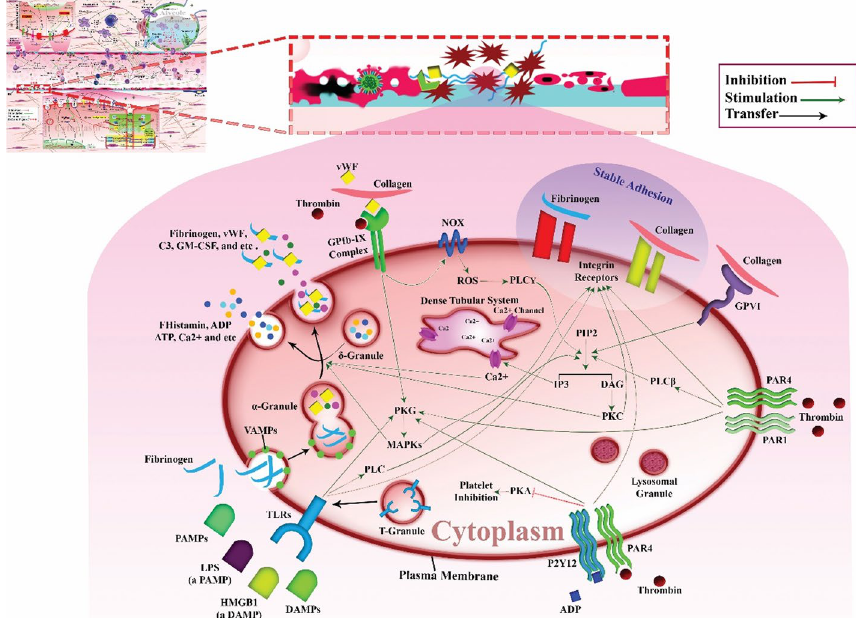
Fig. 3 Platelet receptor/signaling and COVID-19. Low platelet level in some patients with COVID-19 can be due to massively activated platelets. Platelets contain alpha, delta, T, and lysosomal granules. VAMPs may mediate platelet endocytosis. Fibrinogen normally imports into the platelet α-granules and is fused with vWF. Platelets have various receptors: integrins; GP Ib/IX/V; TLRs; thrombin receptors of PAR-1 and PAR-4; ADP receptor of P2Y12; GPVI. In viral infections, TLRs are activated that cause the secretion of complement C3 from alpha granules in platelets. They also release GM-CSF. Complement C3 and GM-CSF stimulate NETosis. SARS-CoV-2 pathogenesis indirectly induces an enhanced capability of VWF to bind to its receptors on platelets. VWF binds to GPIb-IX-induced transient platelet adhesion. Thrombin is another ligand for GPIb-IX. It stimulates the PKG and MAPK pathway and, ultimately, granule secretion. GPVI is known as a collagen receptor. In this pathway, PIP2 hydrolyzes into DAG and IP 3 by PLC2 mediation. DAG and IP 3 are known as secondary messengers. DAG activates PKC isoforms. PKCs are involved in integrin activation and platelet granule secretion. IP 3 increases calcium concentration in cytosol of cells by affecting the dense tubular system channel. Calcium elevation is also required for stable platelet adhesion, granule secretion, procoagulant activity, and clot retraction and collectively almost all platelet functions. PAMPs and DAMPs (such as HMGB1) bind to PRRs, such as TLRs. They prompt platelet activation. TLRs activate PLC2. They also activate the PKG pathway. Minimally three thrombin receptors on human platelet surface have been defined, i.e., GPIb-IX, PAR1, and PAR4. GPIb-IX signaling plays a pivotal role in the assembly of NOX subunits and ROS production. It can also activate PLC through a ROS-mediated signaling pathway. Then, PLC activation leads to DAG and IP 3 formation, which has already been described. PAR1 and PAR4 also activate PLC isozymes and have an effect on the PKG and MAPK pathway. Integrins are also important platelet molecules involved in platelet activity, adhesion, and aggregation, including collagen, fibronectin, etc. They are substantial for the stable adhesion and aggregation of platelets. COVID-19, coronavirus disease 2019; GP Ib/IX/V, glycoprotein, Ib/IX/V; TLRs, Toll-like receptors; GM-CSF, granulocyte–macrophage colony-stimulating factor; C3, complement component 3; SARS-CoV-2, severe acute respiratory syndrome coronavirus 2; PKG, protein kinase G; vWF, von Willebrand factor; MAPK, mitogen-activated protein kinase; PIP2, phosphatidylinositol 4,5-bisphosphate; DAG, 1,2-diacylglycerol; IP 3 , 1,4,5-trisphosphate; PKC, protein kinase C; PLC2, phospholipase C-2; DAMPs, damage-associated molecular patterns; PAMPs, pathogen-associated molecular patterns; NOX, nicotinamide adenine dinucleotide phosphate oxidase; PRRs, pattern recognition